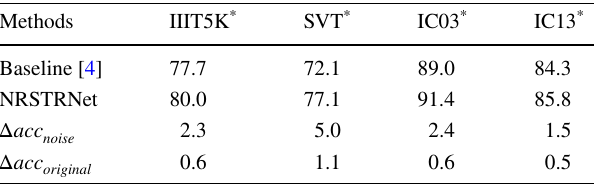
Table 4 Comparison of text recognition accuracy of models on